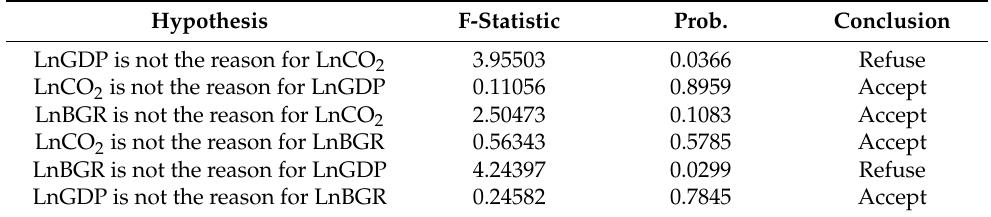
Table 9. GC test